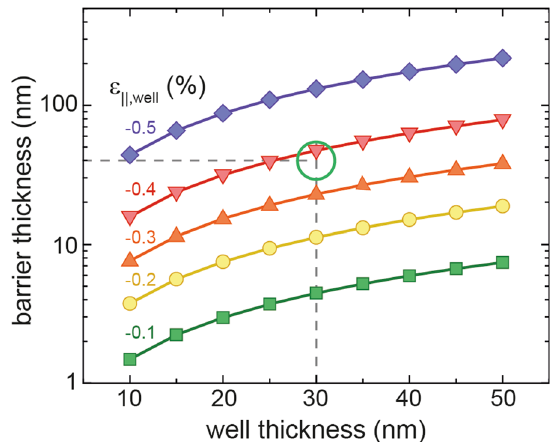
Figure 6. Strain balanced barrier and well thicknesses averaged for GeSn 0.08–0.20 /Si 0.10 GeSn 0.07–0.19 heterostructures with x Sn , well = x Sn, barrier + 1 at.% for different strain values in the well.